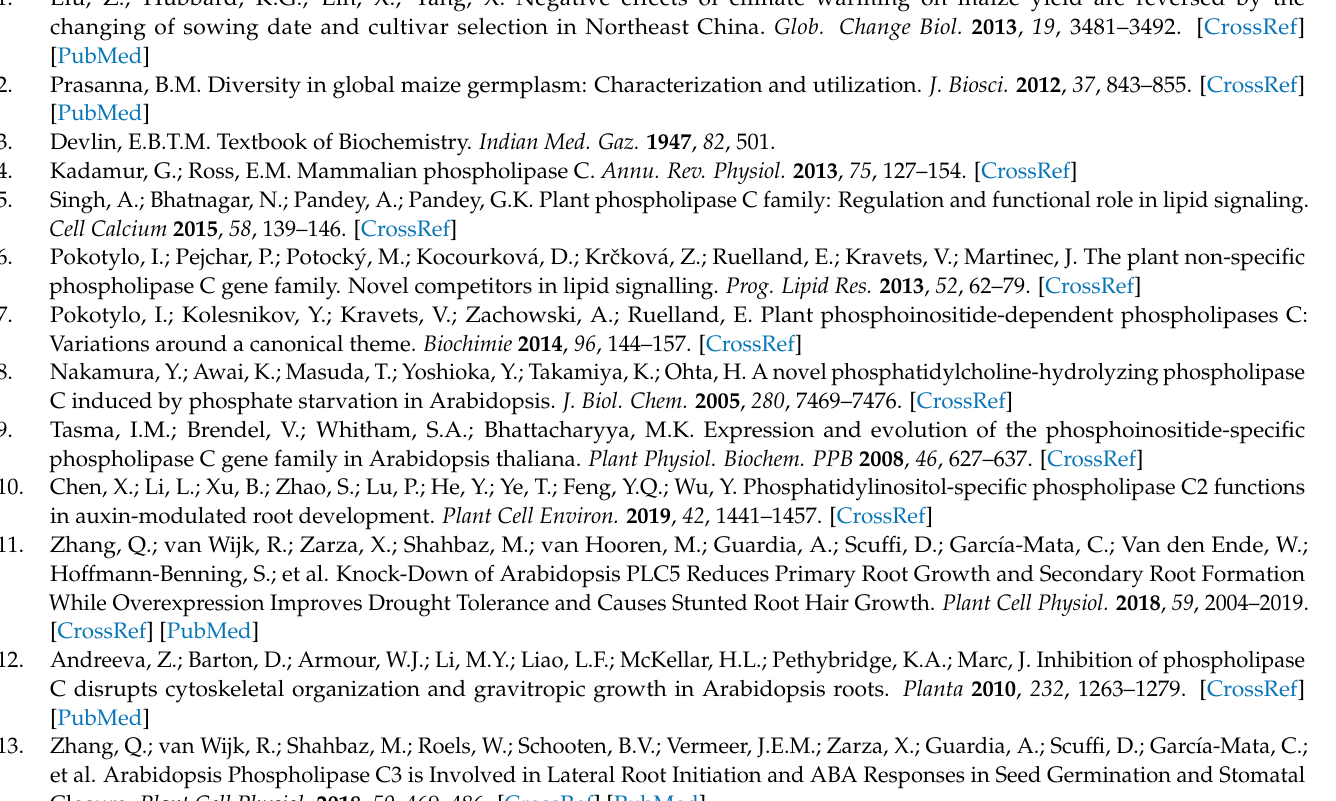
Table S1: Primer list for RT-PCR validation; Table S2: Sequencing data statistics; Table S3: Differential expression of genes related to carbon metabolism under phospholipase C